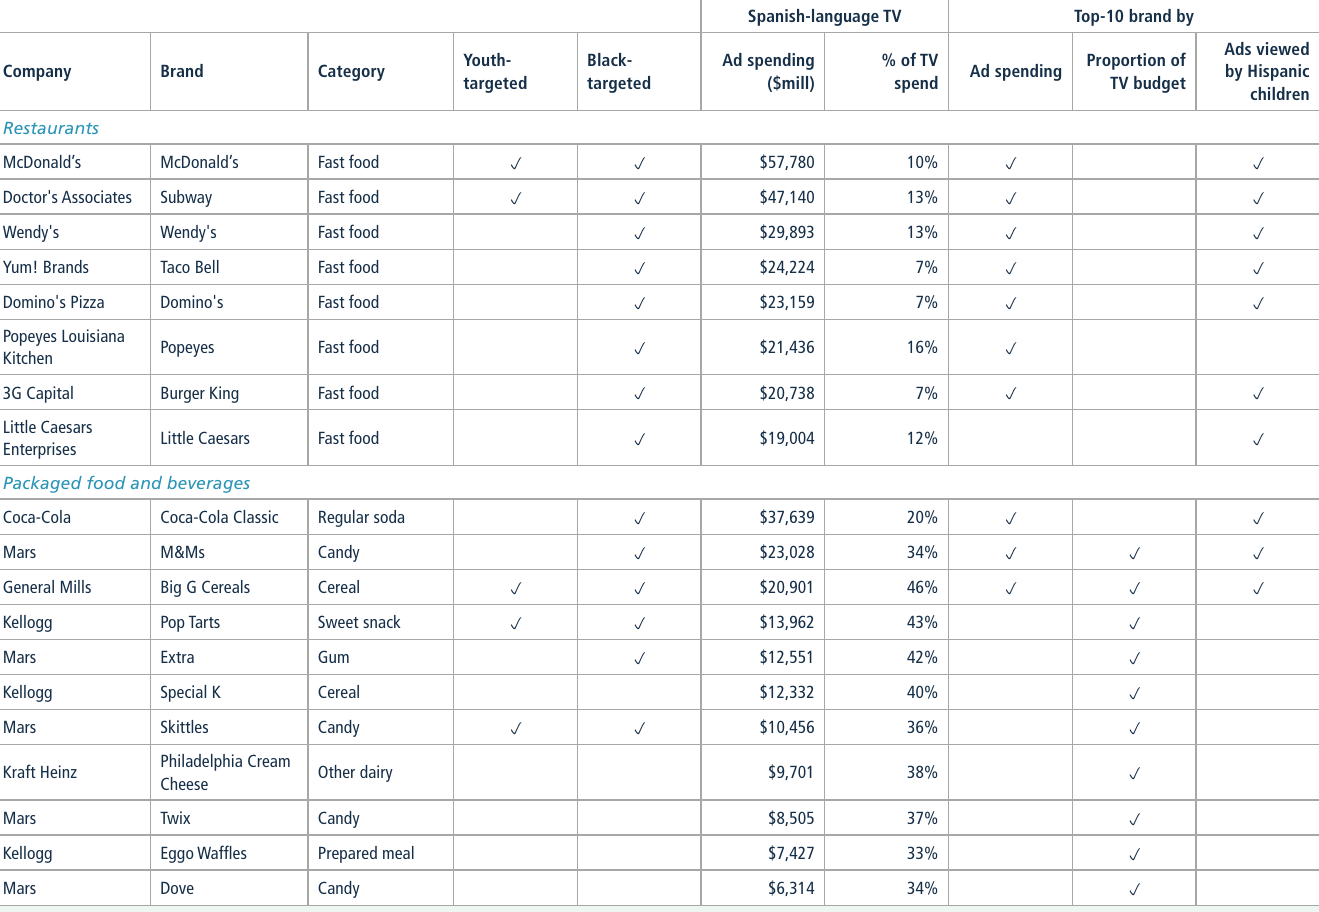
*Among brands spending $5 million or more in advertising on Spanish-language TV: Top-10 brands in 1) spending on Spanish-language TV advertising, 2) proportion of TV ad budgets allocated to Spanish-language TV, and/or 3) number of TV ads viewed by Hispanic children (ages 2-11 years) on Spanish-language TV.